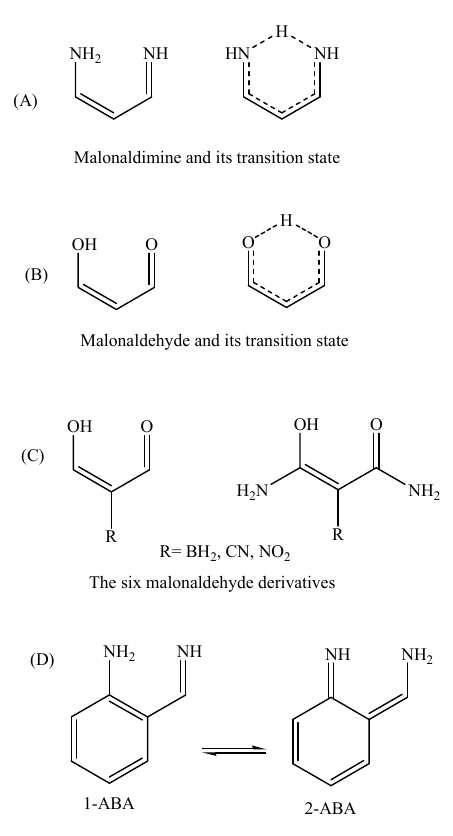
Figure 2. Structures of malonaldimine ( A ); malonaldehyde ( B ) and its derivatives ( C ); and 2-aminobenzaldimine tautomers ( D ).